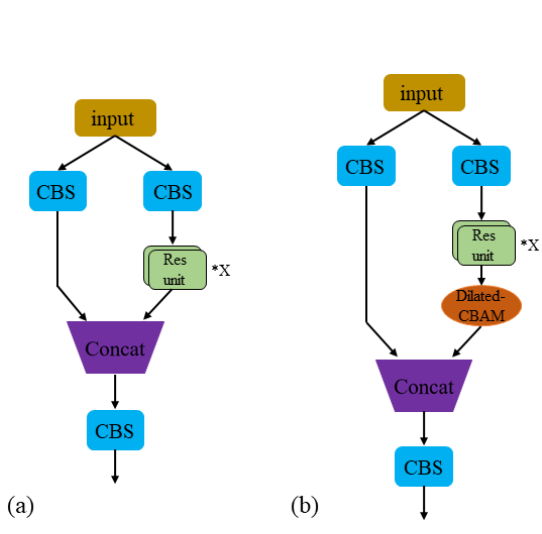
Figure 5. Improvement of CSPX. (a) CSPX of the original model. (b) CSPX of the algorithm in this